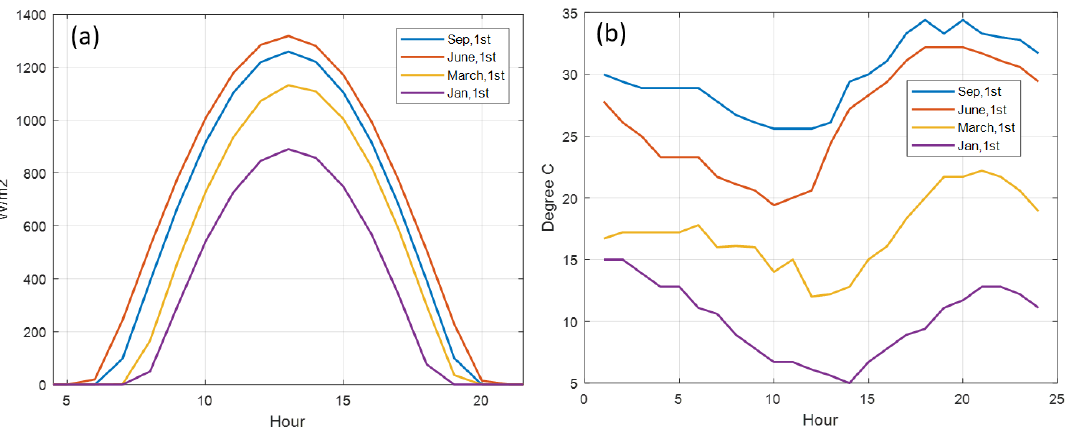
Figure 1. Two main factors that affect the power harvested from solar in Corpus Christi International Airport area (Texas-USA). ( a ) Solar irradiance; ( b ) temperature.